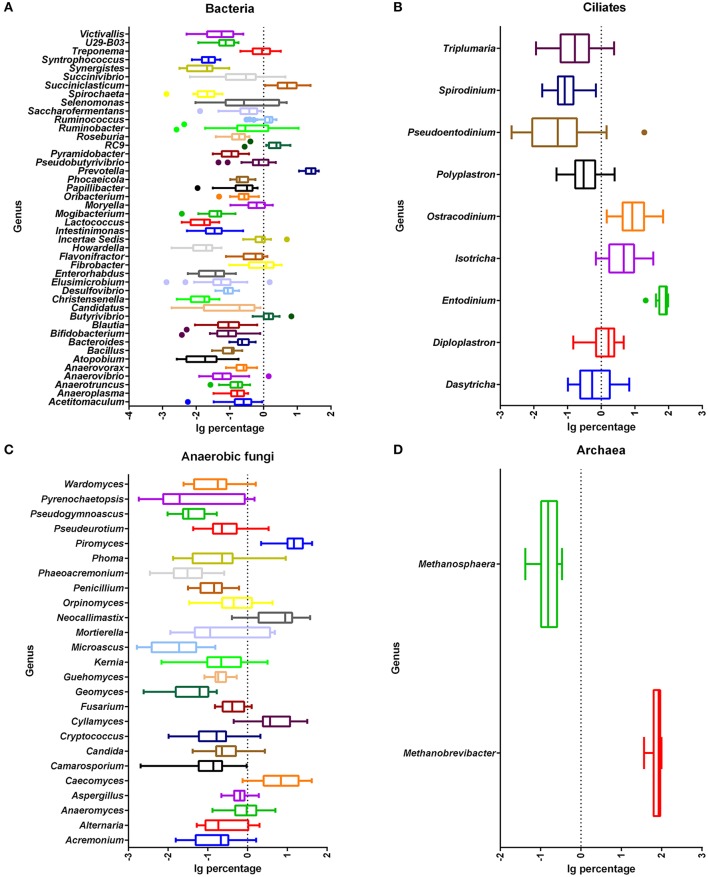
Relative abundance of shared microbial genera across all rumen samples. Abundance of genera of bacteria (A), ciliate protozoa (B), anaerobic fungi (C), and archaea (D). Percentage after log transformation is shown on the x-axis. Boxes represent the interquartile range (IQR) between the first and third quartiles (25 and 75th percentiles, respectively), and the line inside the box defines the median. Whiskers represent the lowest and highest values within 1.5 times the IQR from the first and third quartiles, respectively. Samples with a relative abundance for a given genus exceeding those values are represented as points beside the boxes.